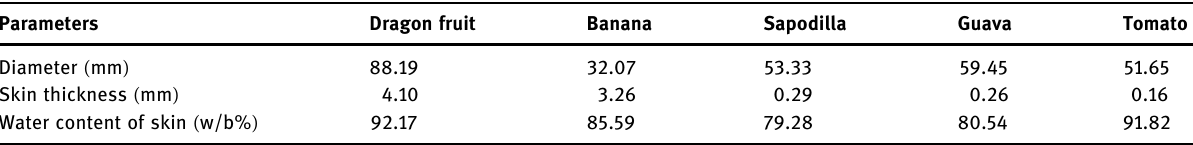
Table 2: Morphological characteristics of fruits used in this study